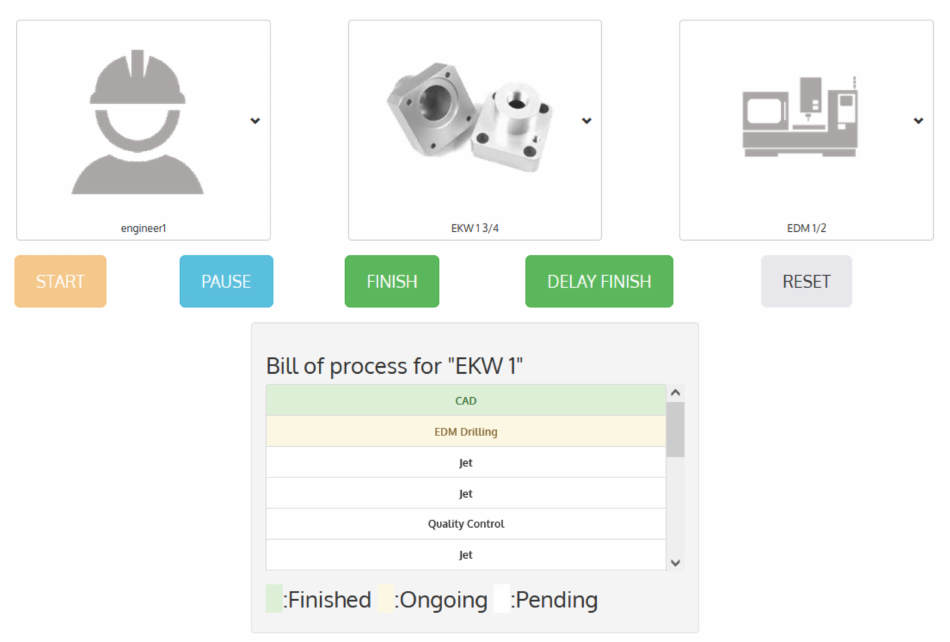
Figure 3. Operator Support App allows user to “Finish” the current process.